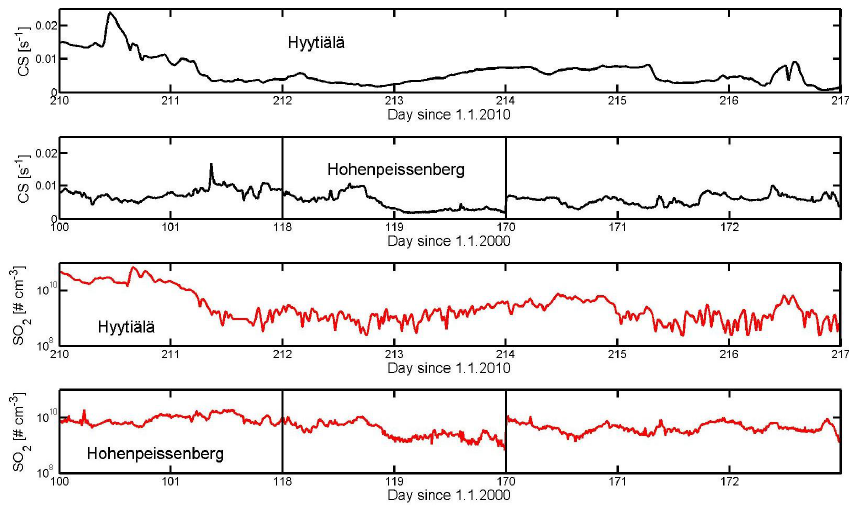
Fig. 2. Measured condensational sink and sulfur dioxide concentrations for the selected periods at both